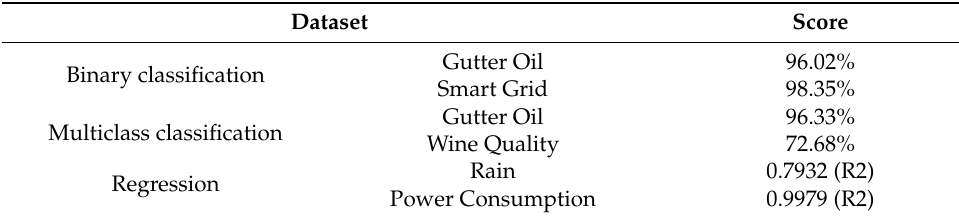
Table 13. The highest-scoring of SVM obtained in different datasets.